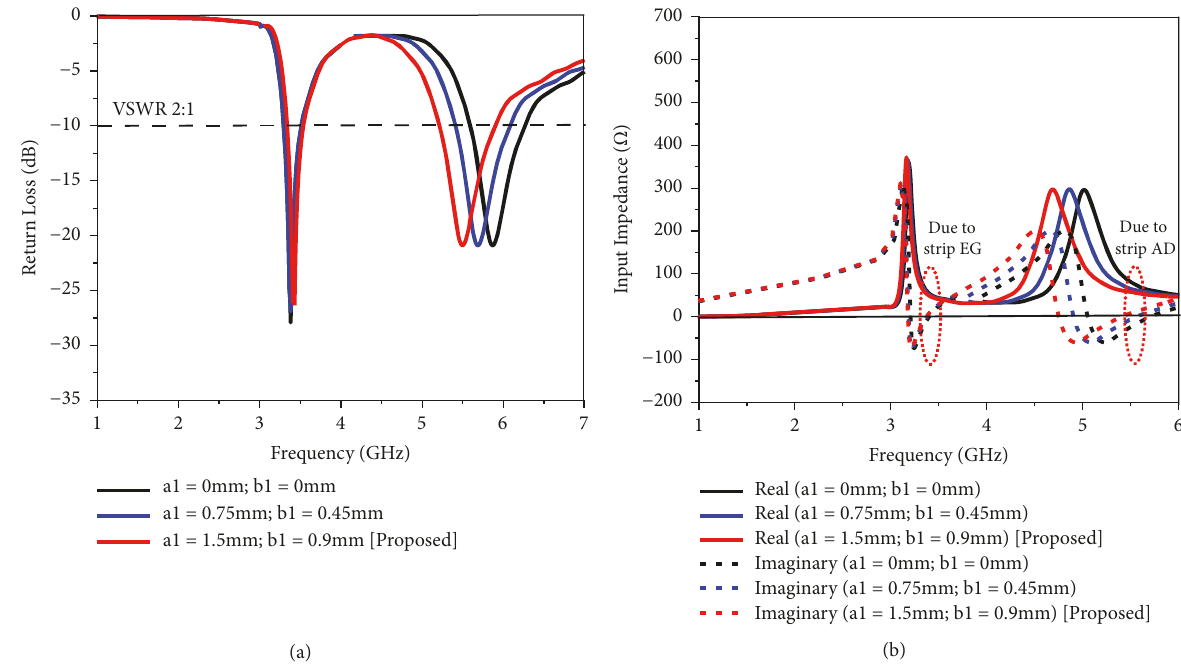
Figure 3: Simulated return loss and input impedance ( Ω ) of the proposed antenna as a function of tuning stub m (a 1 xb 1